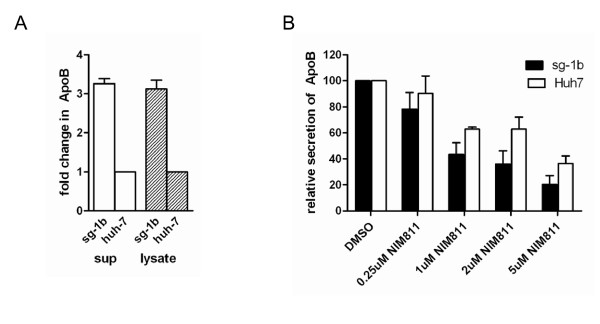
The effect of viral proteins and cyclophilin inhibition on apoB secretion. A) Supernatants and whole cell lysates from equal numbers of sg-1b replicon and naïve Huh7 cells were used to quantify apoB protein by ELISA. The average apoB protein levels from two experiments was normalized to naïve Huh7 cells and graphed as fold change in apoB protein. B) Sg-1b replicon and Huh7 naïve cells were treated with varying concentrations of NIM811 for 48h. ApoB was measured in the supernatants by ELISA. The amount of apoB protein was normalized to DMSO controls for each cell type and plotted as relative secretion ± standard deviation from three experiments.